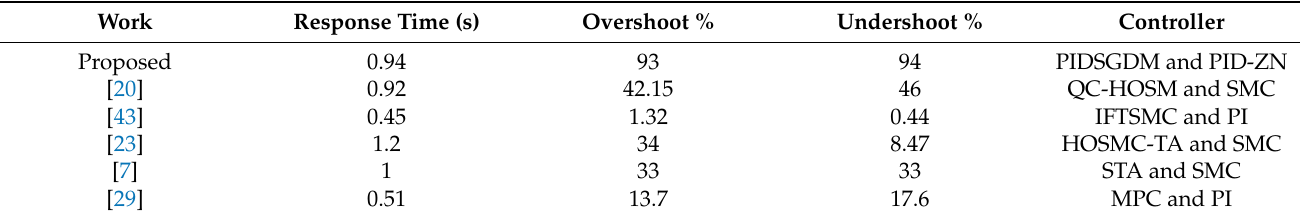
Table 6. Performance comparison between previous